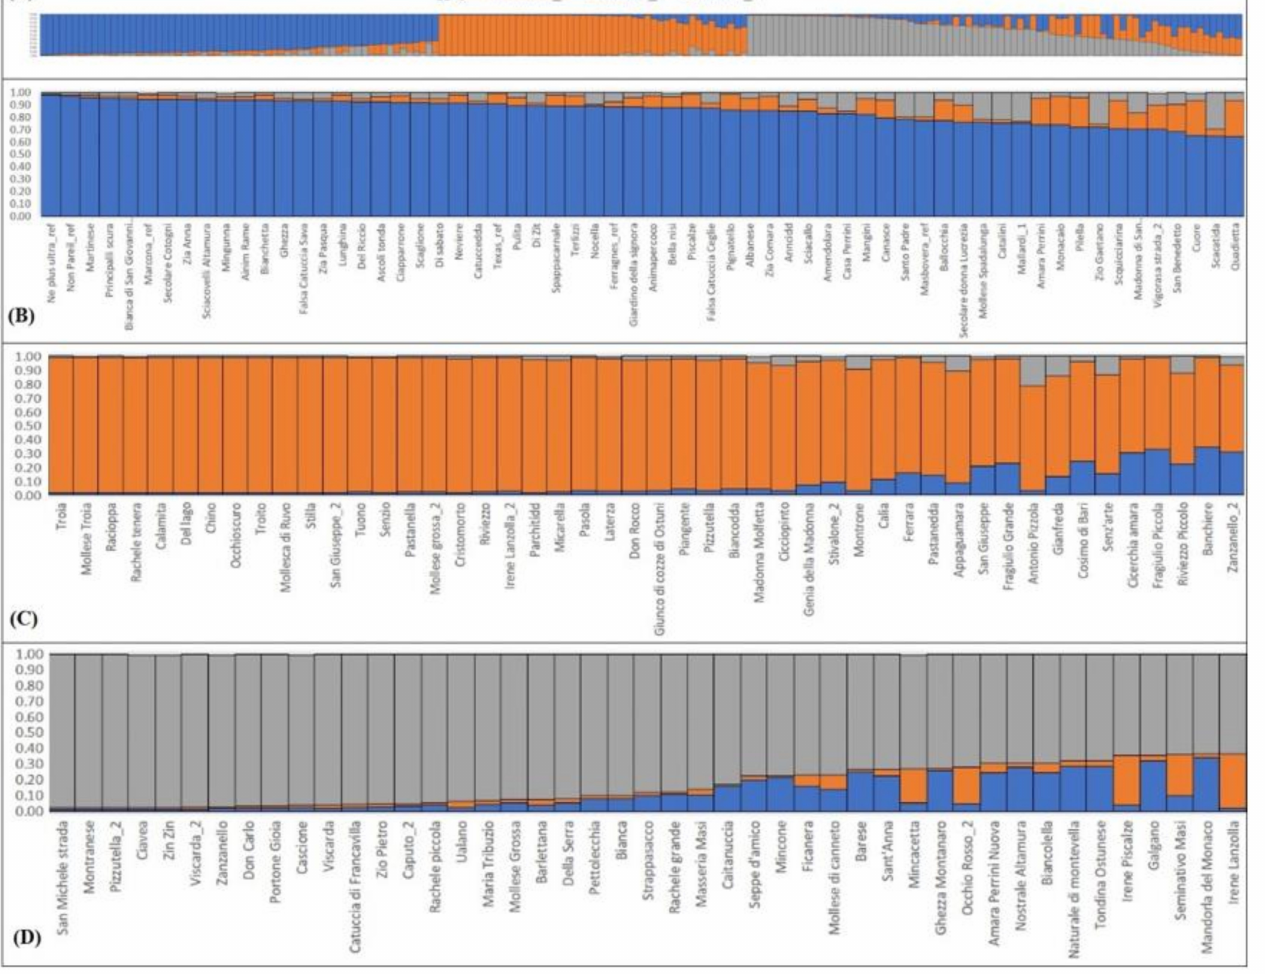
Figure 3. ( A ) Bar plot of all individual almond genotypes generated using STRUCTURE software version 2.3.4 [51]. For the burning phase, 30,000 iterations were set, followed by 1000 repetitions for K values, ranging from 1 to 10, with 10 runs for K. The three reconstructed subpopulations are distinguished by different colors: blue for cluster 1 ( B ), orange for cluster 2 ( C ) and grey for cluster 3 ( D ). Each genotype is represented by a vertical bar that can be portioned into different colored segments indicating its genetic background. Multiple colors show the admixed genetic constitution of some individuals. Cluster assignment was based on a membership threshold set at